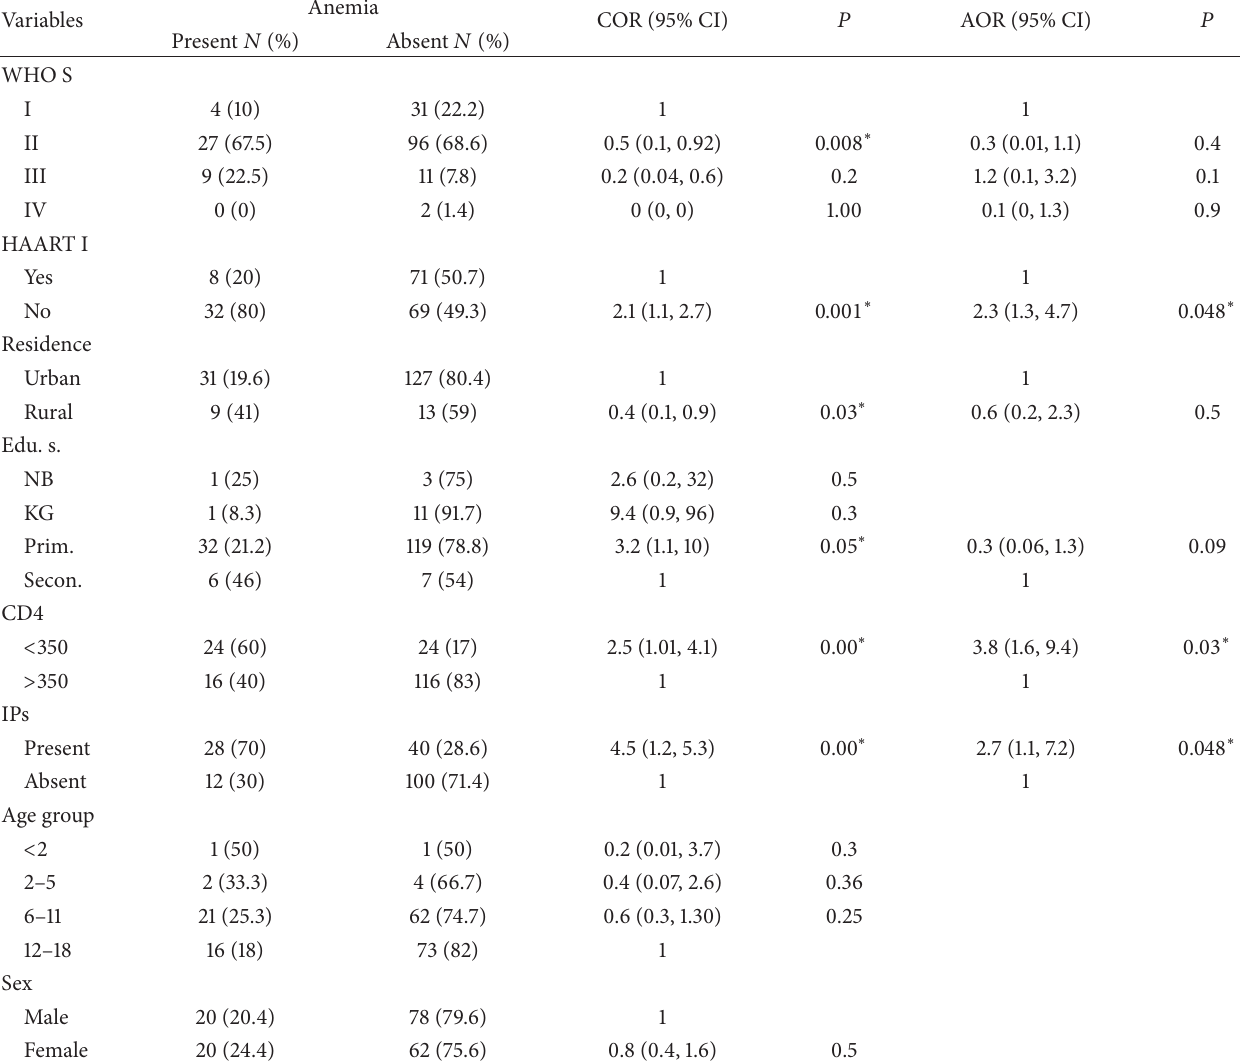
Table 3: Association of risk factors with anemia in pediatric HIV/AIDS patients attending Zewditu Memorial Hospital from August 5, 2013, to November 25, 2013, Addis Ababa, Ethiopia ( 𝑁 = 180 ).